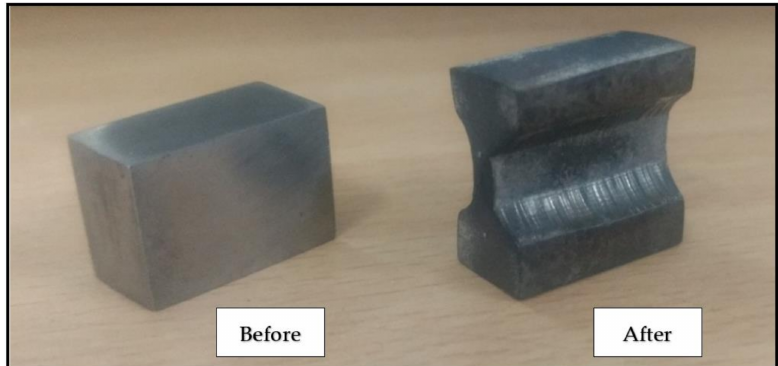
Figure 1. Sample before and after the compression test in gleeble.